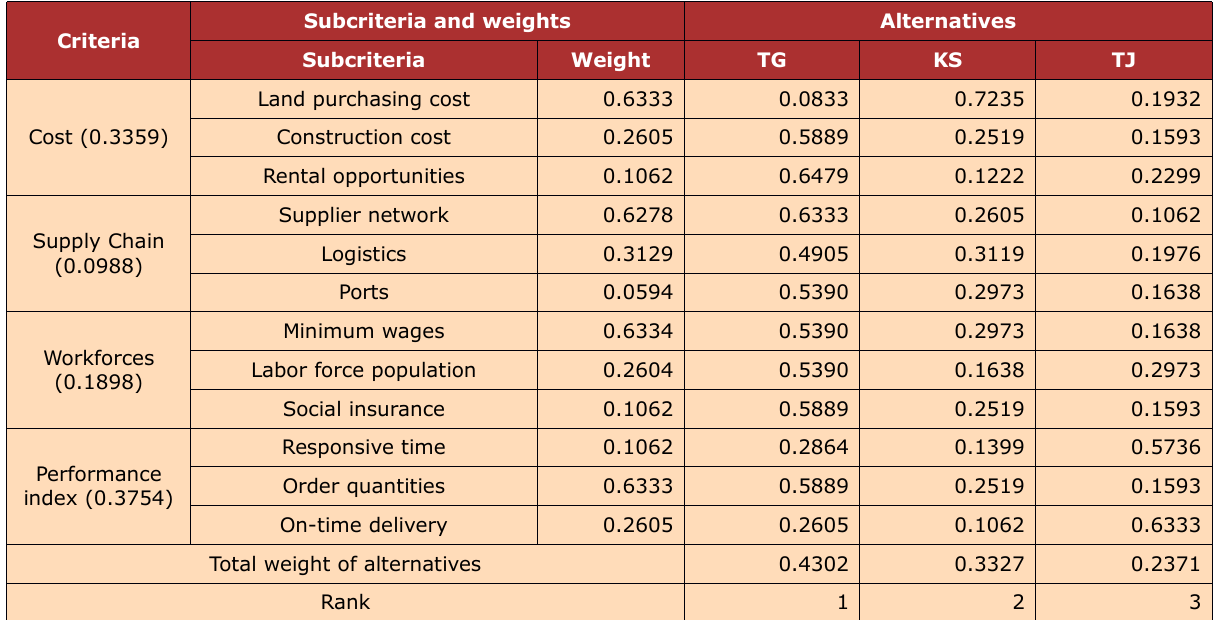
Table 12. The ranking of the alternatives for four